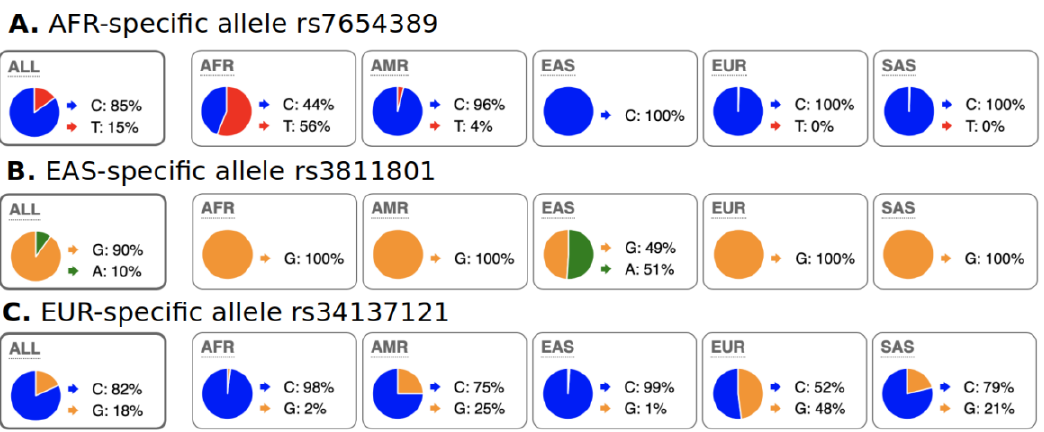
Figure 2. Examples of ARSA SNPs for Africa, East Asia, and Europe from population data of 1000 genome project as they presented on the Ensembl genome browser. A pie chart of regional SNP allele frequencies taken from the Ensemble website “Allele and genotype frequencies by population” (https://useast.ensembl.org/Homo_sapiens/Variation/ accessed on 20 May 2022) through SNP RS-identifiers. ( A ) Allele “T” is present only in Africa but absent in other continents (small frequency of “T” in Americas is due to admixture in 1000 Genomes populations). ( B ) Allele “A” is present only in East Asia and nowhere else. ( C ) Allele “G” is present in Europe but absent in Africa and East Asia. The presence of the “G” allele in Americas and South Asia (SAS) is due to admixture of Euro- peans with populations from these regions. African populations from the USA (ASW and ACB from 1000 Genomes) also have the “G” allele with 4 to 9% frequency that resulted in its 2% frequency in the total African sample. These ASW and ACB were excluded from our Step-2 calculations. Distri- bution of ARSA SNPs among continents is present in Table 1.